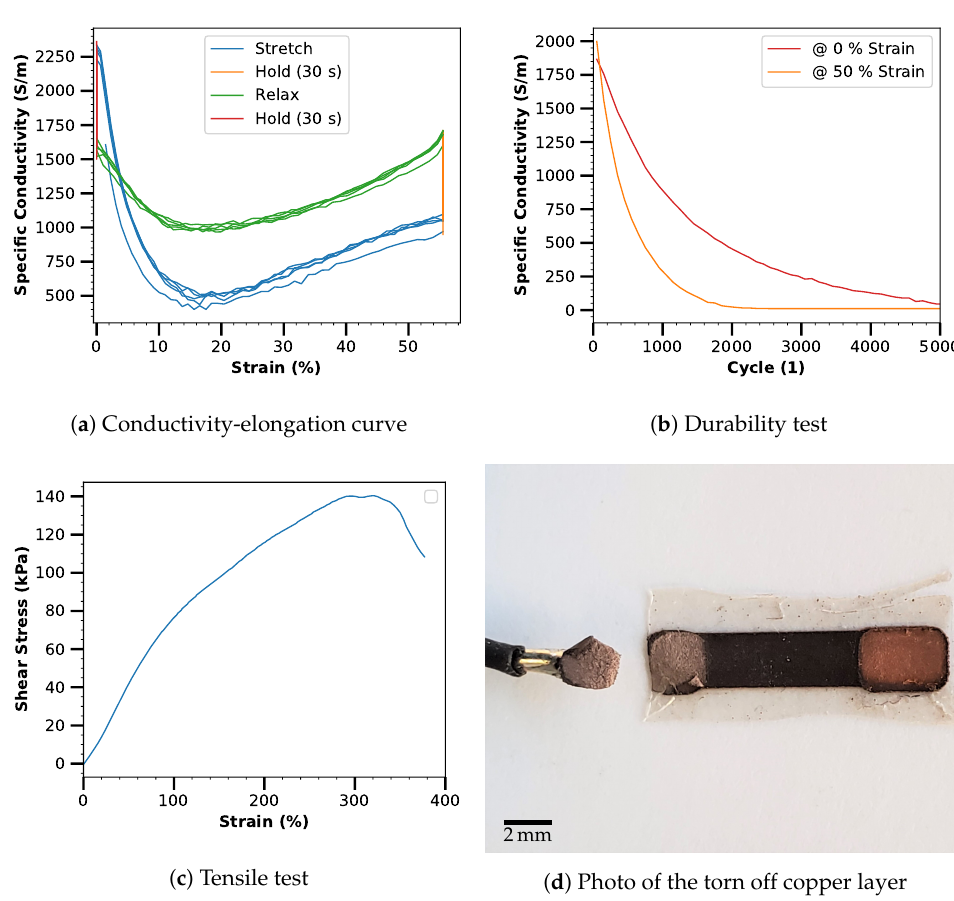
Figure 6. Electromechanical characterization of the laser-fabricated elastic conductor path: Strain de- pendence of conductivity in five consecutive cycles ( a ), conductivity in the stretched and unstretched states over the span of 5000 strain cycles ( b ), stress-strain diagram to determine the strength of the bonding of the metallic copper layer ( c ), as well as photograph of the (inverted) soldered cable with the copper layer torn off and the residual layer of the silicone composite electrode adhering ( d ). Sharpness and brightness of the photo were adjusted for better